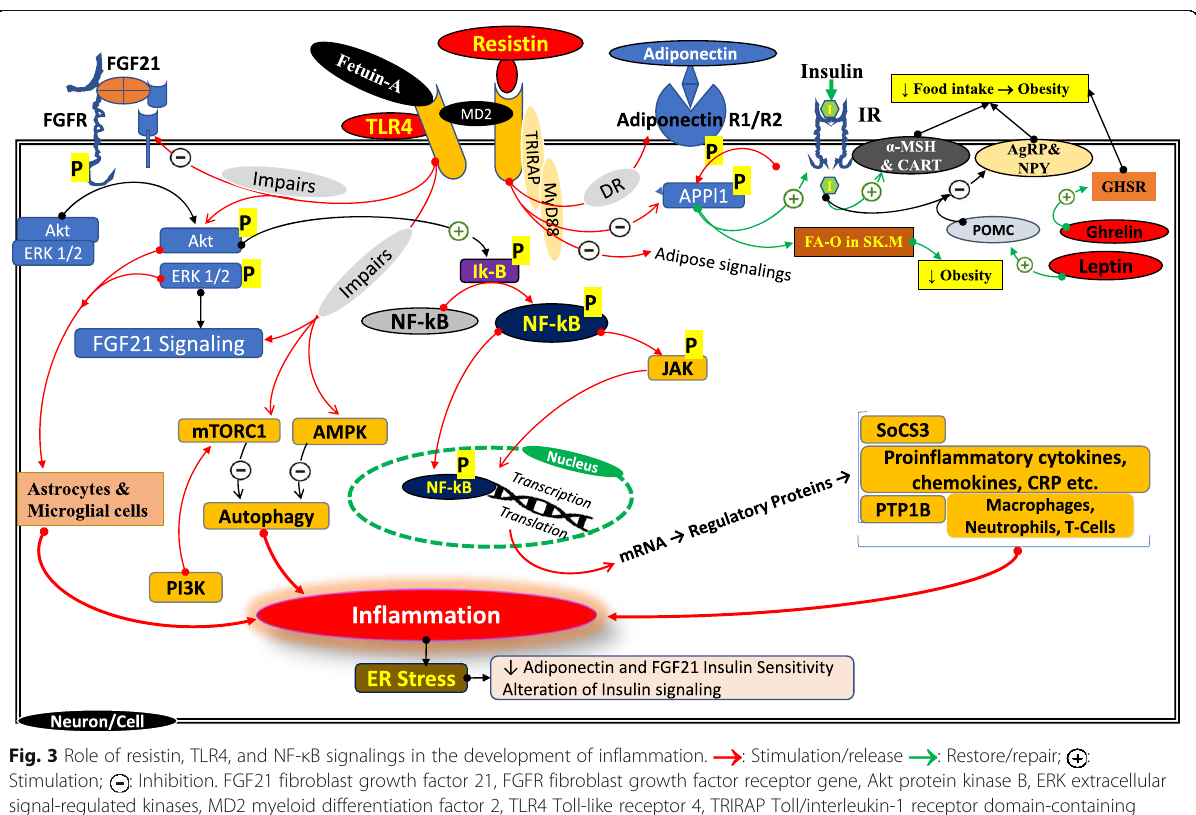
Fig. 3 Role of resistin, TLR4, and NF- κ B signalings in the development of inflammation. Stimulation; : Inhibition. FGF21 fibroblast growth factor 21, FGFR fibroblast growth factor receptor gene, Akt protein kinase B, ERK extracellular signal-regulated kinases, MD2 myeloid differentiation factor 2, TLR4 Toll-like receptor 4, TRIRAP Toll/interleukin-1 receptor domain-containing adapter protein, NF-kB nuclear factor kappa-light-chain-enhancer of activated B cells, Ik-B I κ B kinase, mTORC1 Mammalian target of rapamycin complex 1, AMPK AMP-activated protein kinase, PI3K phosphatidylinositol-3-kinase, JAK c-Jun N-terminal kinases, MyD88 myeloid differentiation primary response 88, DR diabetic retinopathy, APPl1 adaptor protein, phosphotyrosine interacting, IR insulin resistance, α -MSH & CART α - melanocyte-stimulating hormone & cocaine and amphetamine-regulated transcript, AgRP& NPY Agouti-related protein & neuropeptide Y, GHSR growth hormone secretagogue receptor, POMC proopiomelanocortin, FA-O in SK.M skeletal muscle lipid oxidation, SoCS3 suppressor of cytokine signaling 3, PTP1B protein tyrosine phosphatase 1B, ER endoplasmic